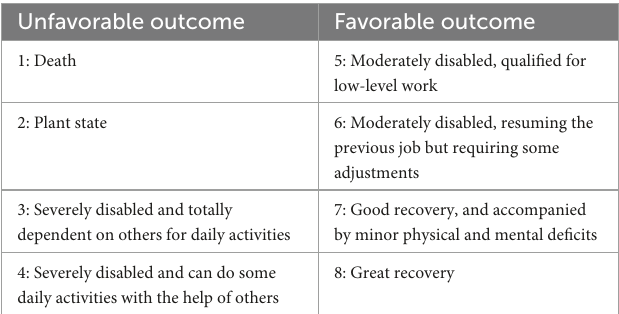
outcome (GOSE 1–4; severe disability or death). GOSE was divided into eight levels (Wilson et al., 1998; Table 1